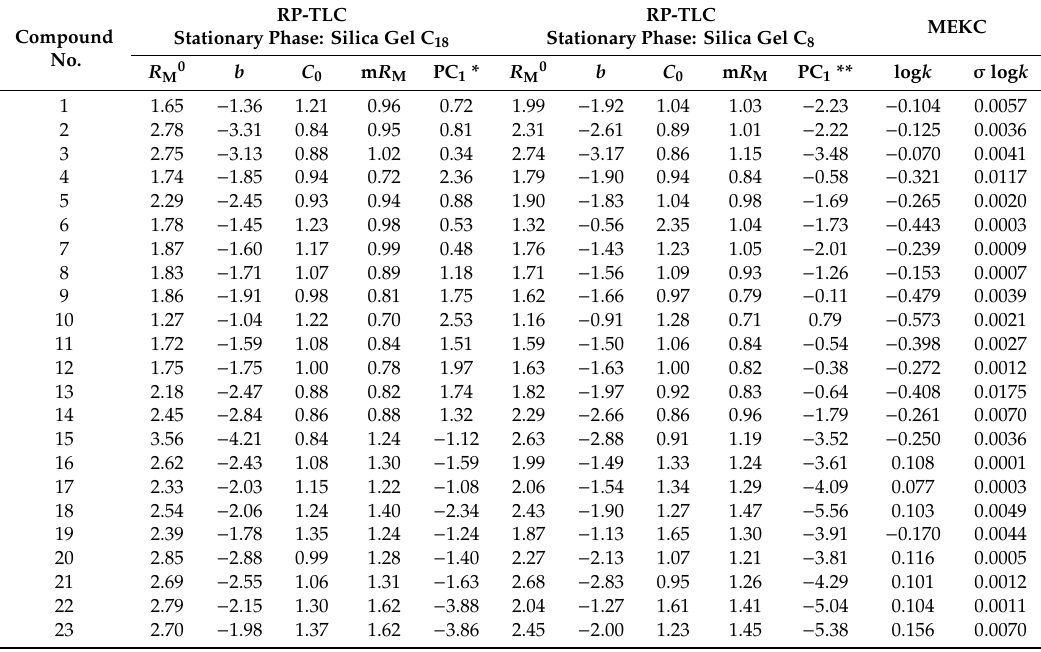
Table 3. Chromatographically determined lipophilicity